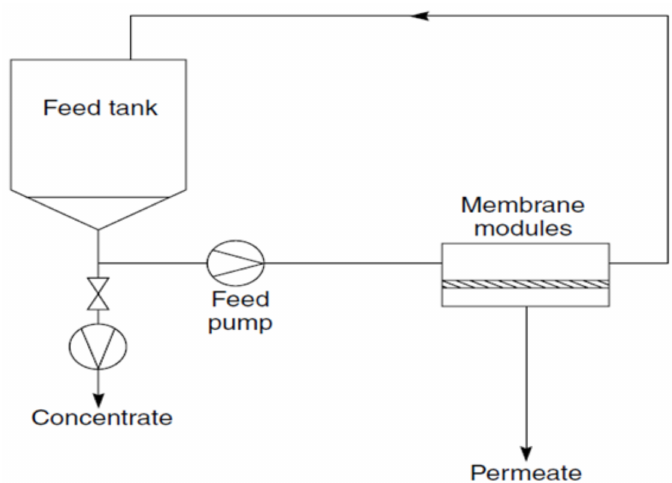
Figure 1. Schematic flow of a batch ultrafiltration process.